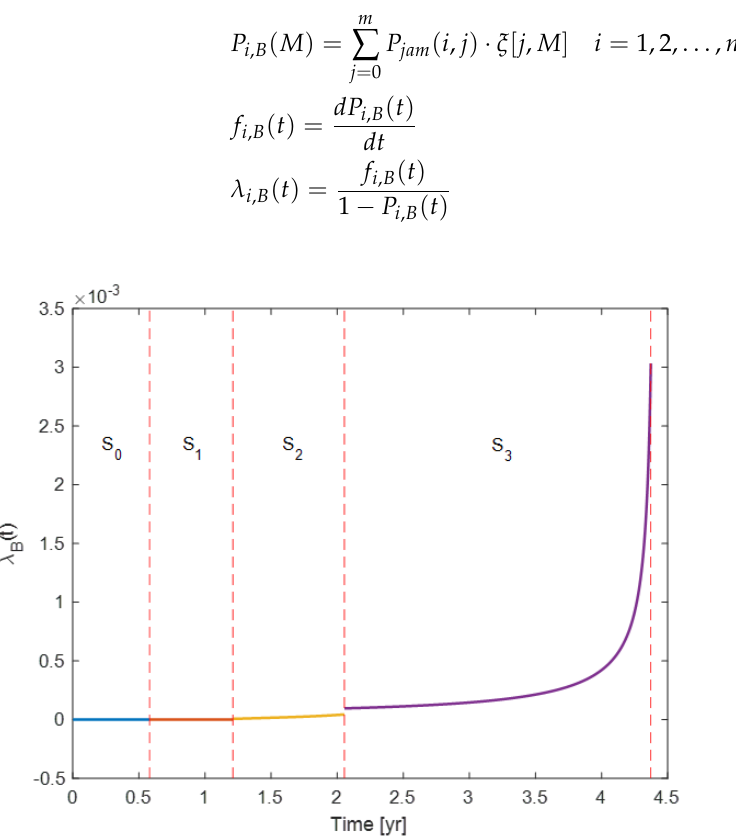
Figure 6. Transition rate of